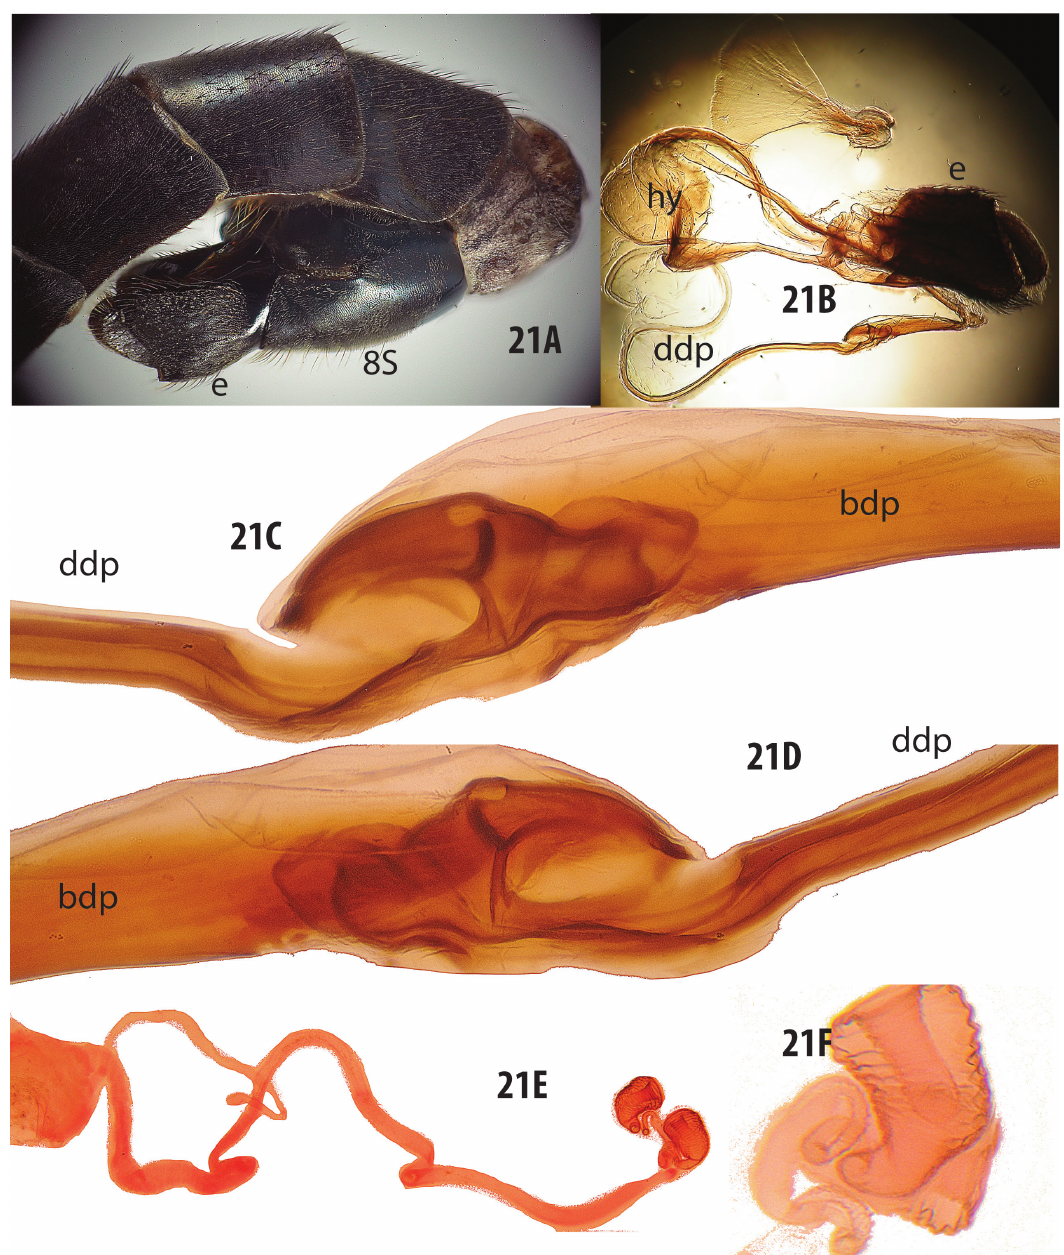
Fig. 21. Mesoconius acca sp. nov., internal characters, Peru. A . Abdomen, ♂. B . Male terminalia. C–D . Phallic bulb and adjacent parts of distiphallus, left (C) and right (D) views. E–F . Spermatheca and associated structures. Abbreviations: bdp = basal distiphallus; ddp = distal distiphallus; e = epandrium; hy =